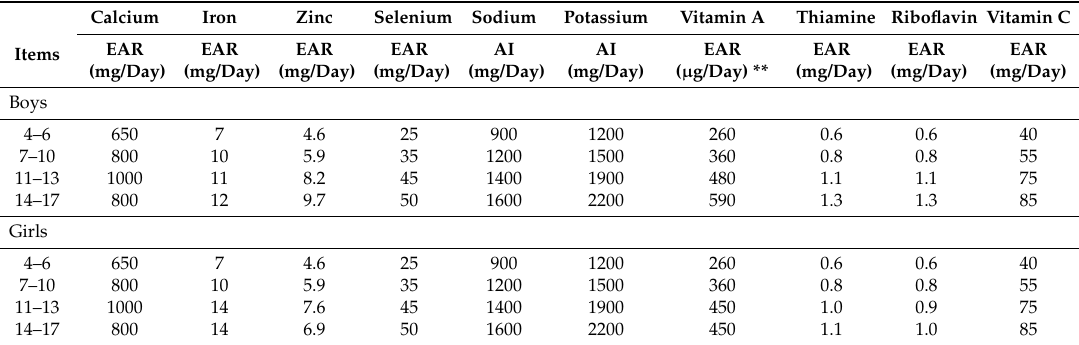
Table A1. EARs or AIs for selected micronutrients for Chinese children